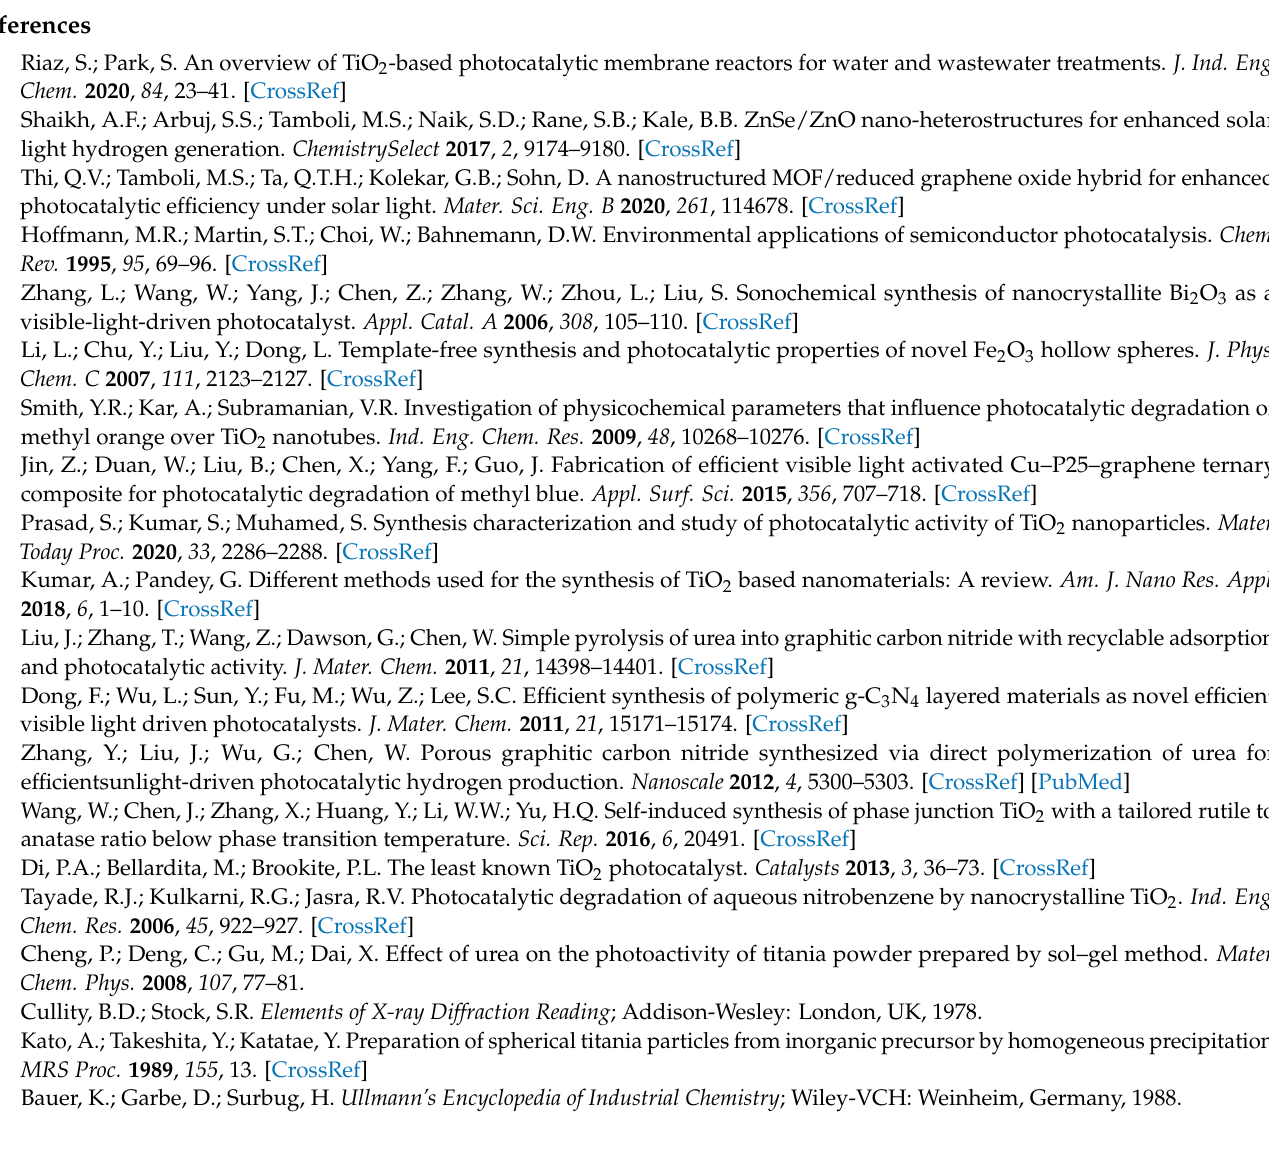
Table S2: Comparison of photodegradation performance of TiO 2 with reported